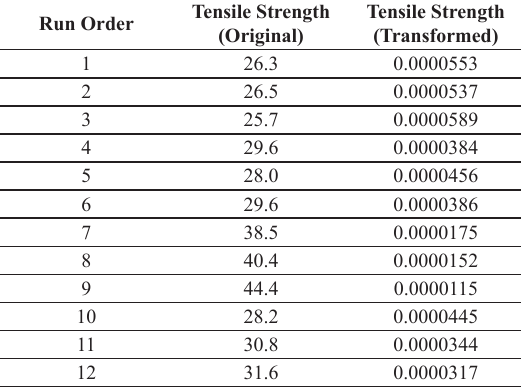
Table 4. Original and transformed tensile strength values.